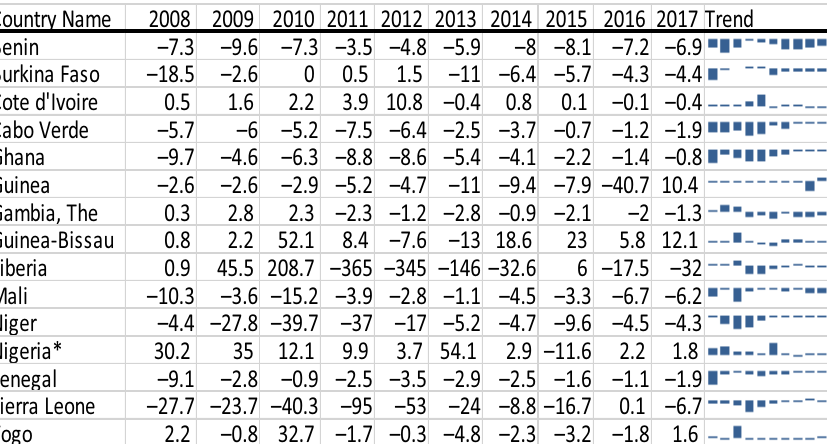
Figure 5. countries Source: Authors' calculations based on data from World Bank